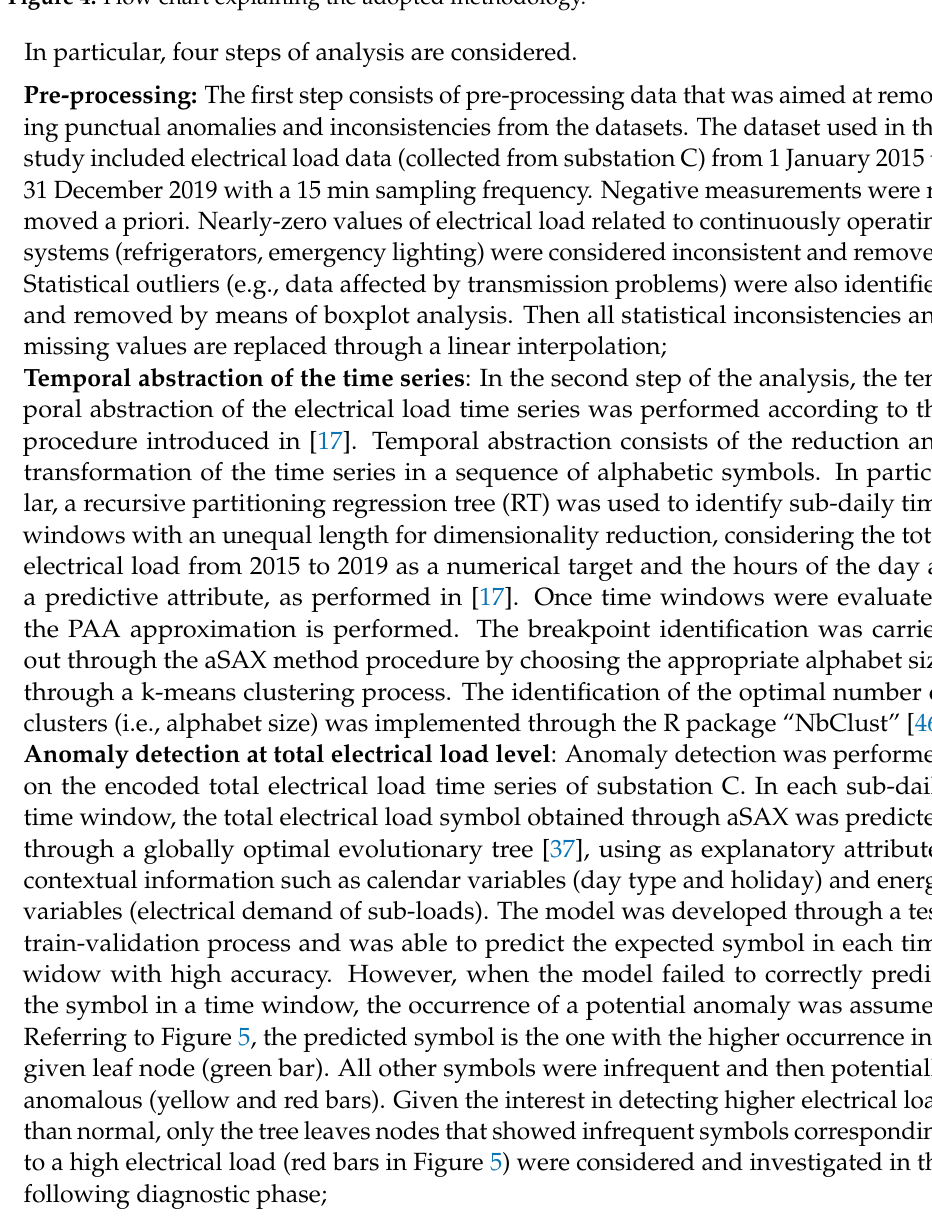
Figure 4. Flow chart explaining the adopted methodology.